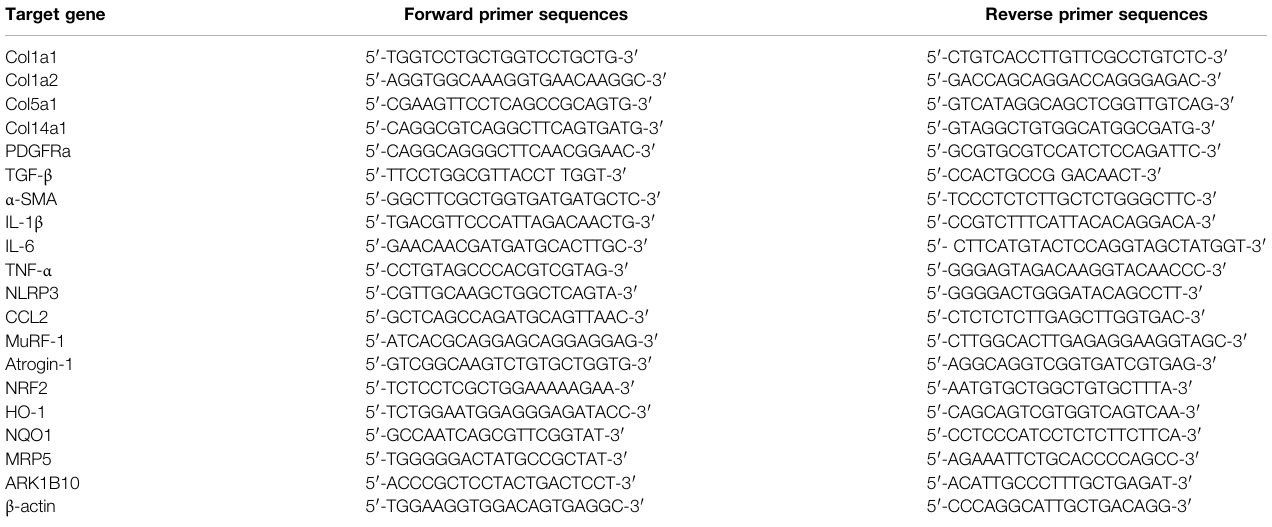
TABLE 1 | Primers for real-time